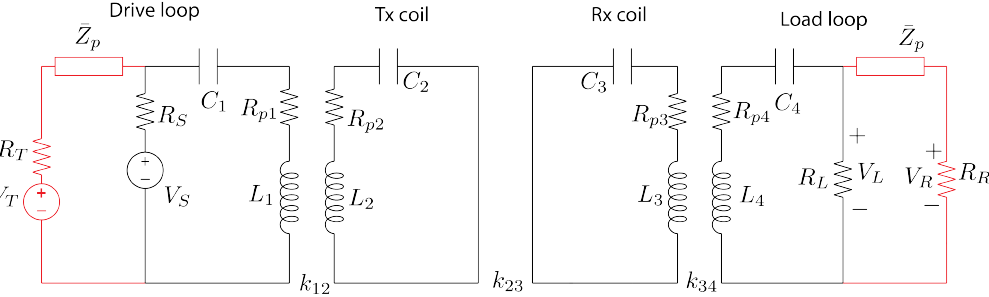
Figure 2. Power and data from the outer coils, with the inclusion of the parallel filter.